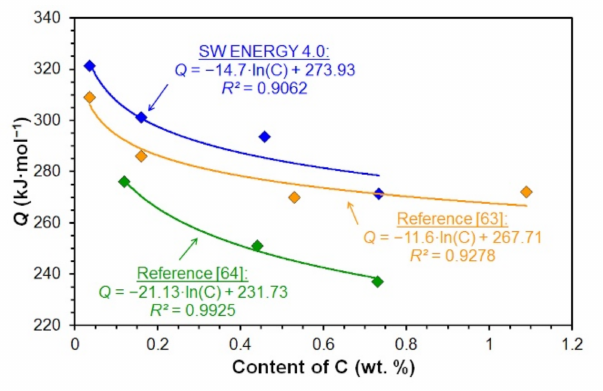
Figure 18. Comparison of values of hot deformation activation energy of non-alloyed carbon steels obtained in the literature